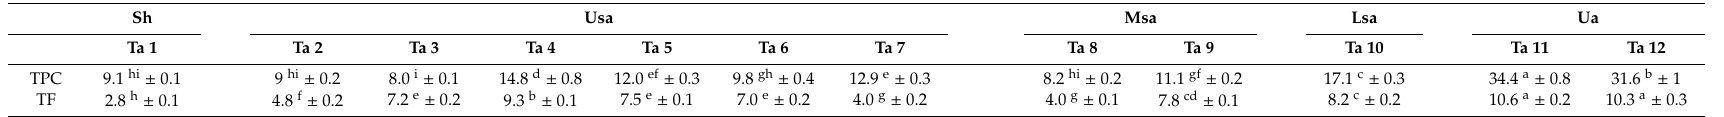
Ta 1–12 correspond to the code number as detailed in Table 1. Sh, Usa, Msa, Lsa, and Ua: sub humid, upper semi-arid, mean semi-arid, lower semi-arid, and upper arid bioclimatic zones, respectively (See Table 1). TPC: total phenolic compounds, TF: total flavonoids. Numbers in lines followed by the same letter are not significant at p > 0.05 (Duncan’s multiple range